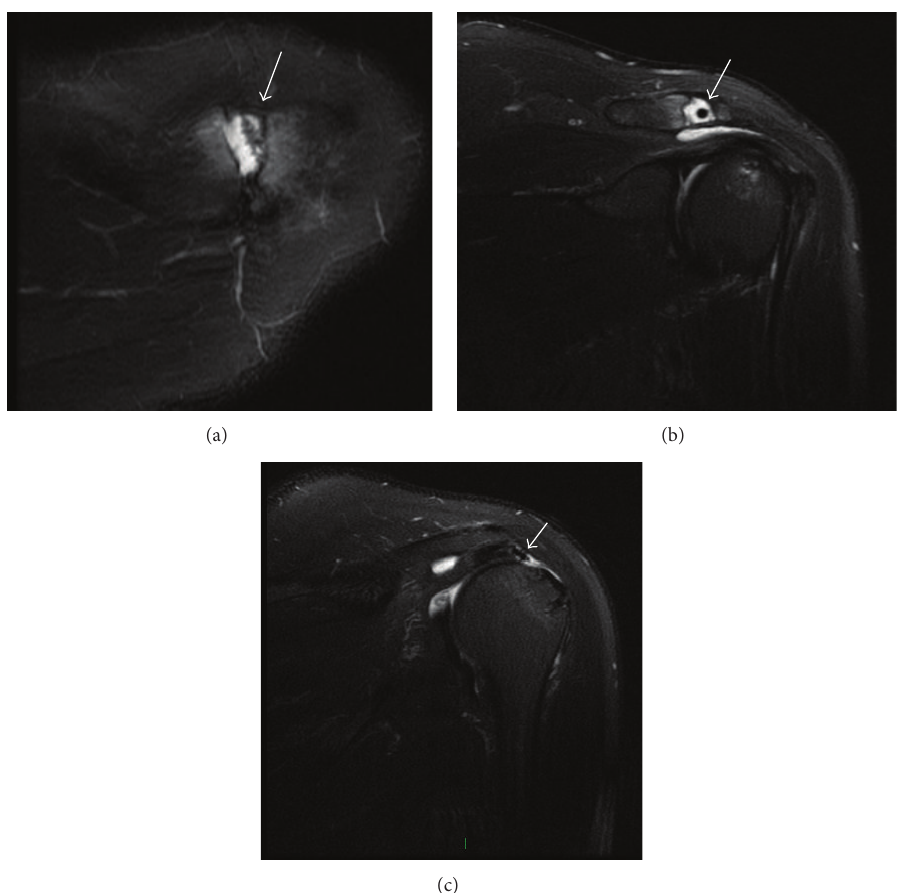
Figure 1: T2-weighted MRI of the left shoulder. (a) Axial view and (b) coronal view showing suture anchor located in the acromioclavicular joint (white arrow); (c) coronal view showing the suture anchor attached to the tendon stump of a retear of the rotator cuff (white